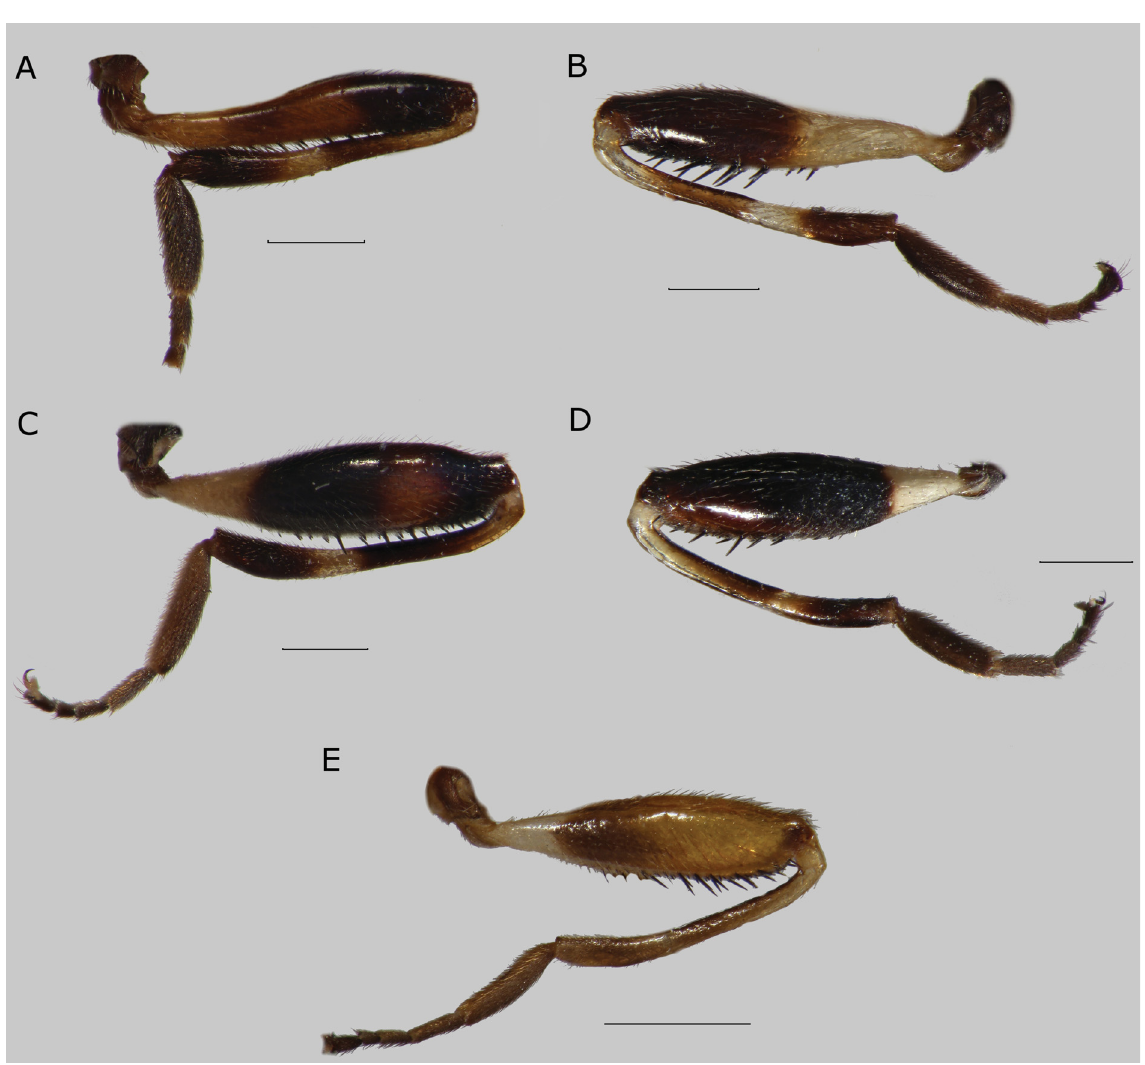
Fig. 95. Metaleg, anterior view. A . Sphegina (Asiosphegina) plautus sp. nov., holotype, ♂ , China. B . S. ( A. ) setosa sp. nov., holotype, ♂ , Nepal. C . S. (A .) strigillata sp. nov., holotype, ♂ , Vietnam. D . S. (A.) umbrosa sp. nov., holotype, ♂ , China. E . S. (A.) varidissima Shiraki, 1930, ♂ , Taiwan, yellow form. Scale bars = 0.5